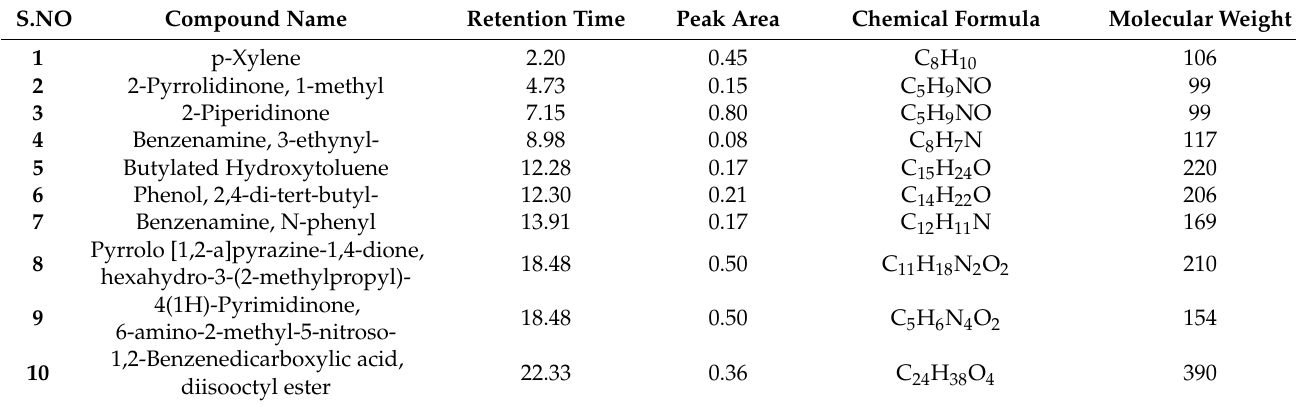
Figure 12. Original Dye Brown 706 13 C NMR. Figure 13. 1 H NMR after Pseudomonas aeruginosa degradation.